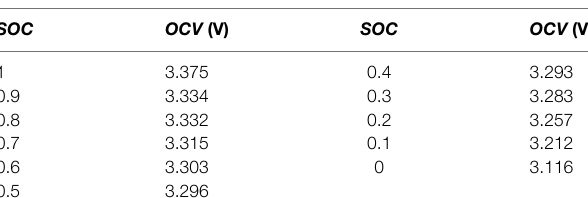
TABLE 1 | OCV − SOC experimental